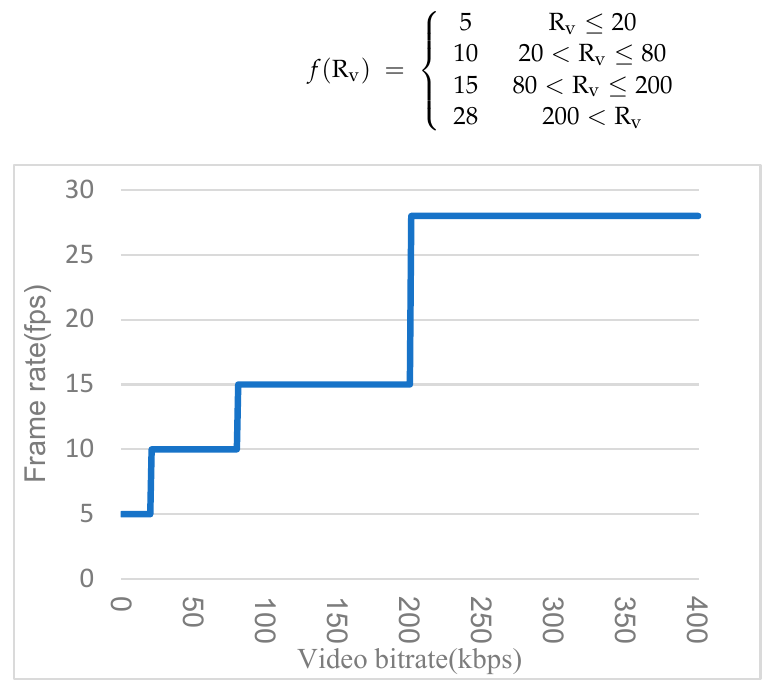
Figure 4. The relationship between the amount of data received and the frame rate.